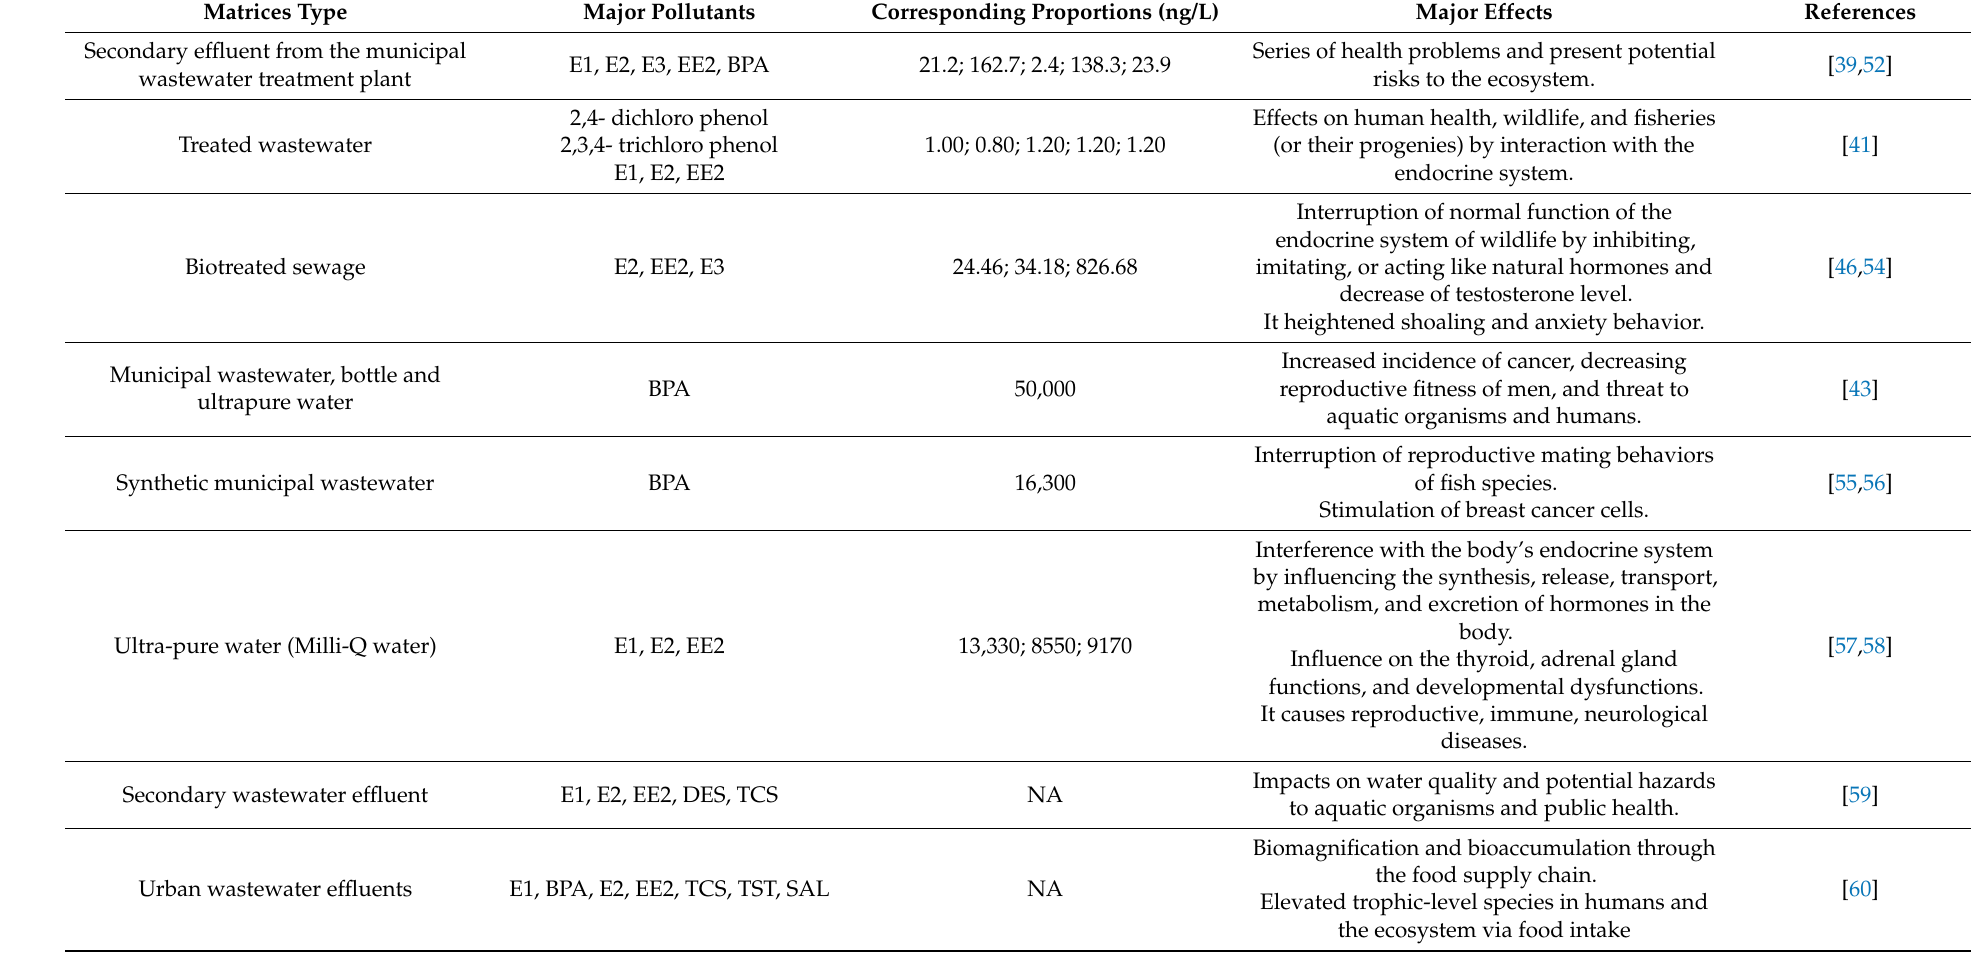
Table 1. Published information on different concentrations and deleterious effects of endocrine-disrupting compounds from different